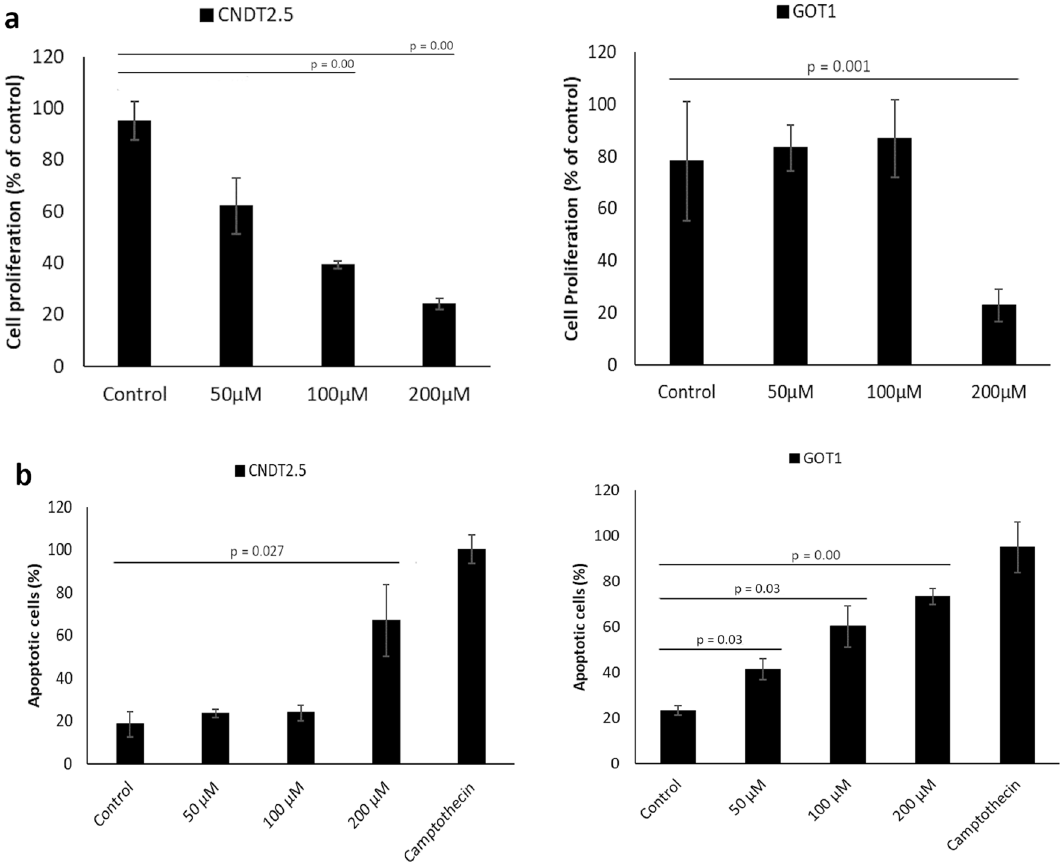
Figure 4. CPI-1205 treatment reduced proliferation and induced apoptosis in SI-NET cells. ( a ) Cell proliferation was determined in CNDT2.5 and GOT1 cells after treatment with CPI-1205 for 72 and 48 h, respectively. ( b ) Treatment effect on apoptosis was analyzed by quantifying cytoplasmic histone-associated- DNA-fragments under the same conditions. Incubation with 0.1 μg/mL camptothecin for 48 h was used as a positive control. Data shown are means ± SD of